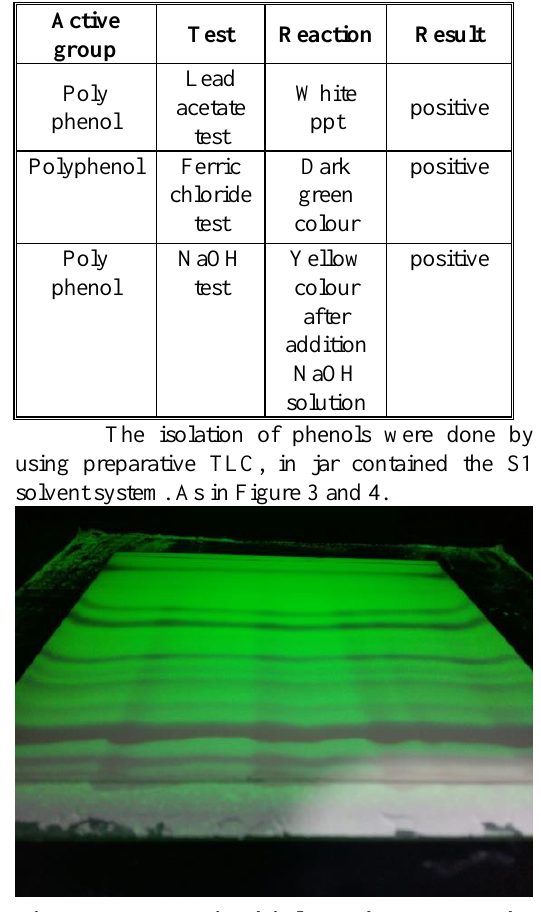
Figure 3. Preparative thin layer chromatography plate for ethyl acetate fraction on silica gel GF254 developed in the S1 system, detection by UV light at